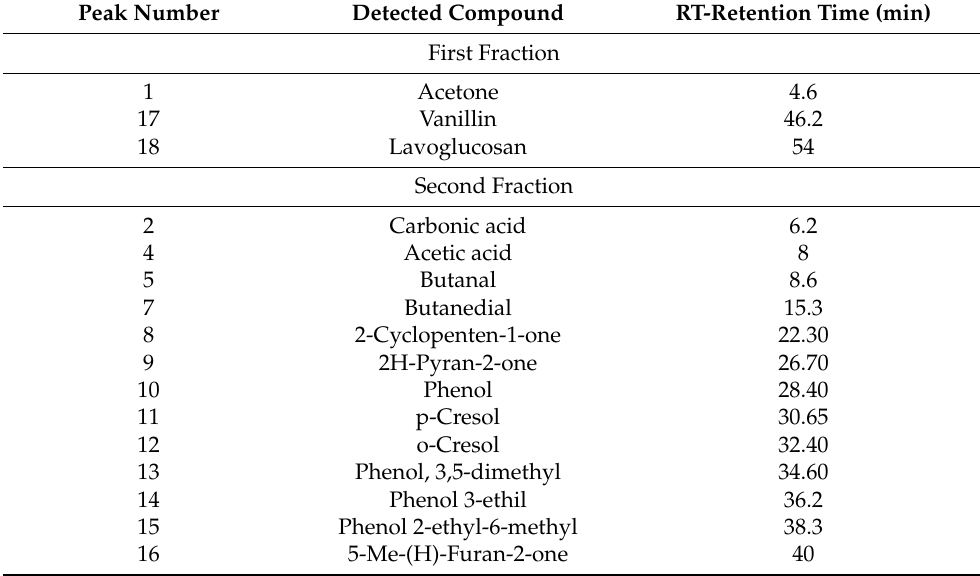
Table 6. Components of bio-oil from fast pyrolysis of pinewood that were collected in the three fractions and detected by GC-MS/FID